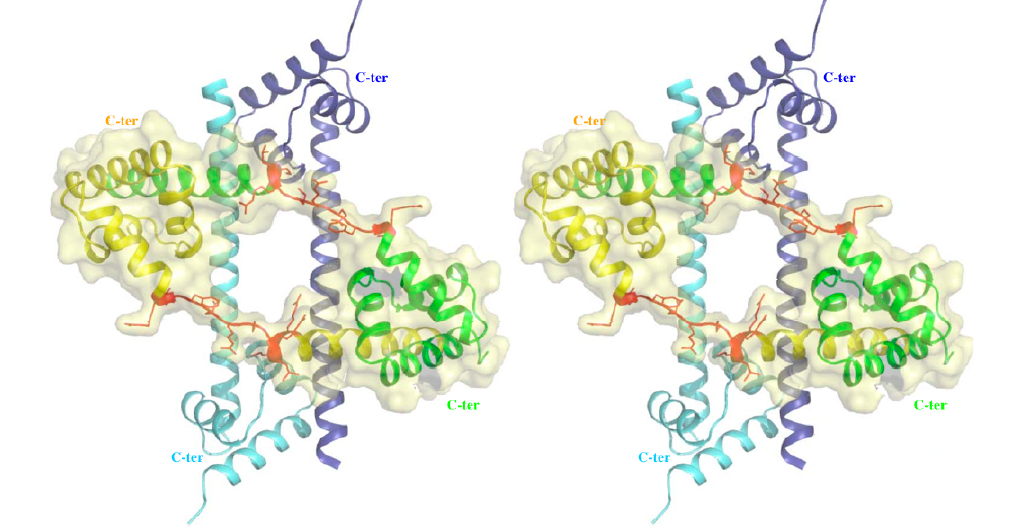
Figure 3. Crystal structure of unbound L20 protein . Stereoview of the heterotetramer of the asymmetric unit. The two folded monomers are represented by blue and cyan ribbons. The two partly unfolded monomers are represented by green and yellow ribbons. The unfolded regions of the α 2 helix are represented in red. The folded and unfolded dimers mutually stabilise each